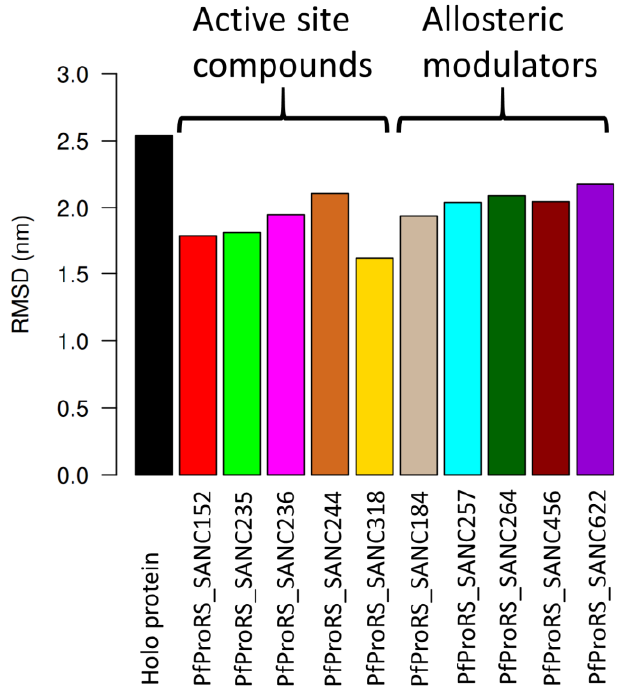
Figure 7. Bar graph representation of protein backbone root mean square deviation of FEL stable states compared to initial structures. The holo protein and protein-ligand complexes are shown on the X-axis.